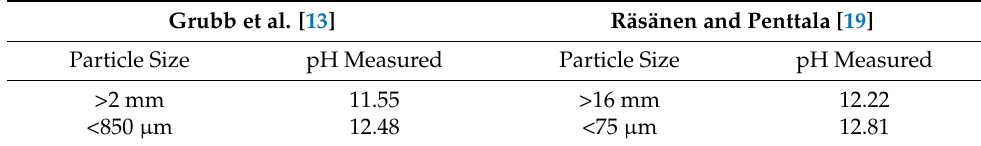
Grubb et al. [13] Räsänen and Penttala [19] Particle